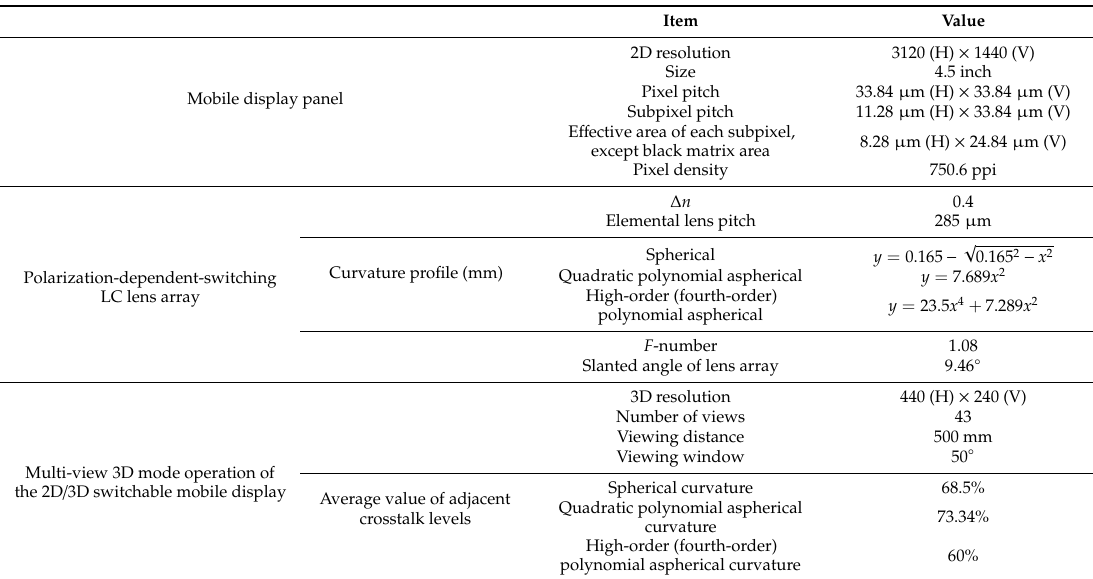
Table 3. Specifications of the multi-view 2D / 3D switchable mobile display for LC GRIN lenses with di ff erent interfacial